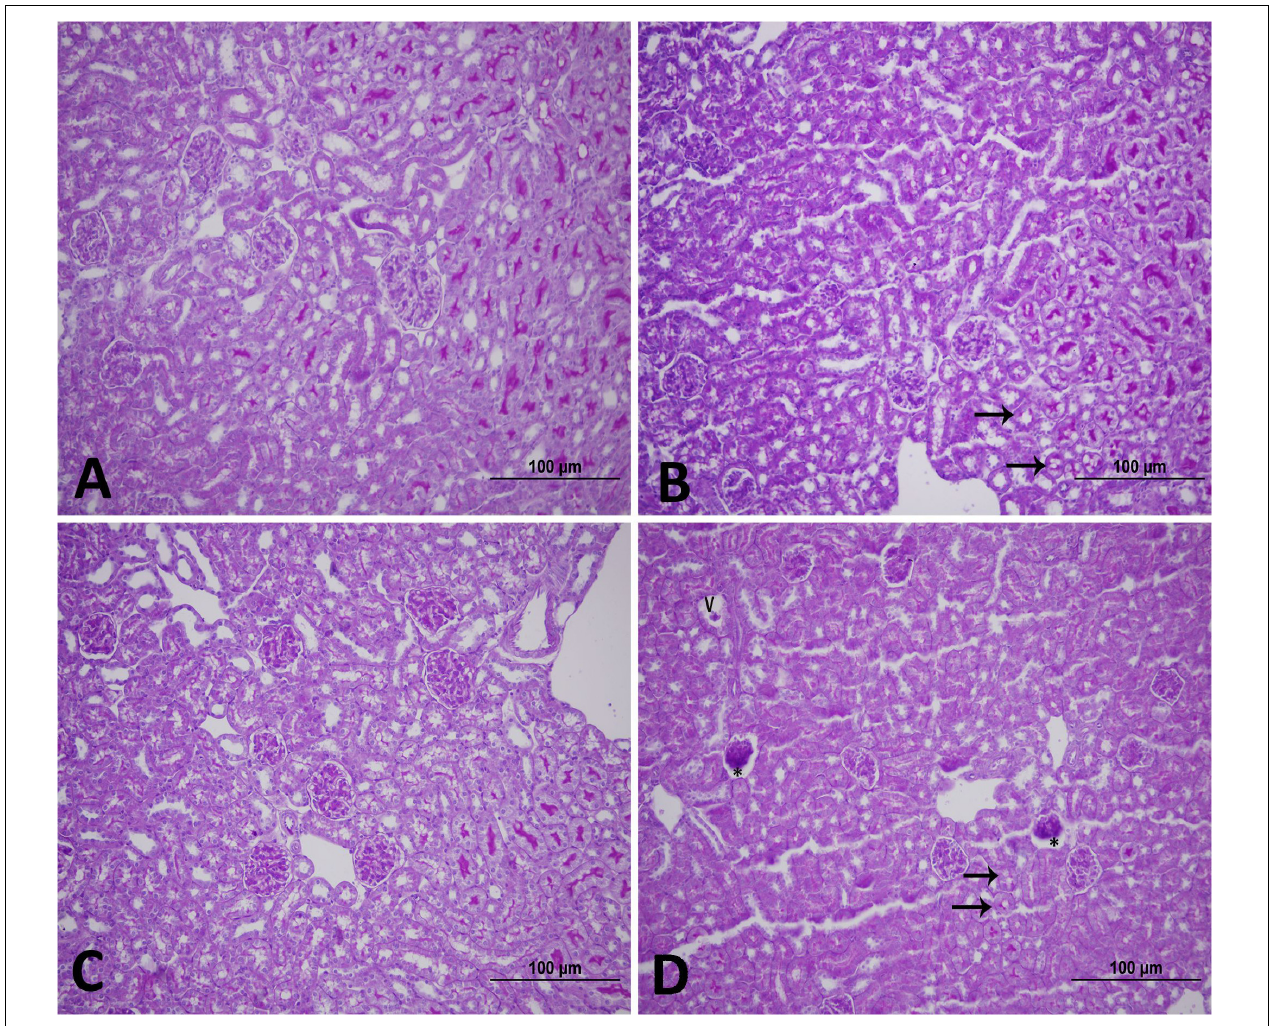
FIGURE 1 | Representative light [Periodic acid-Schiff (PAS) staining] micrographs of kidney tissues of mice at the end of 1-week exposure period to air (control, A ), 1-week exposure period water pipe smoke (WPS) exposure (B) , 4-week exposure period to air (control, C ) or 4-week exposure period to WPS (D) . Note that the kidney sections of mice exposed to WPS showed vacuoles (V), glomerular degeneration ( ∗ ), and loss of loss of PAS staining (arrows). Scale bar = 100 µ m; n = 12.